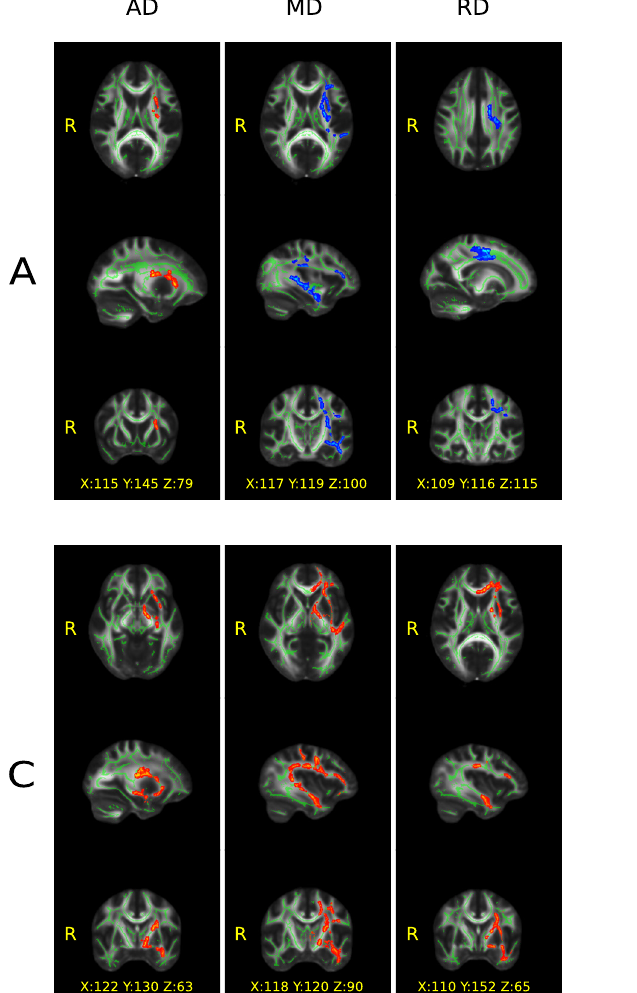
PLOS ONE | https://doi.org/10.1371/journal.pone.0187939 January 5,